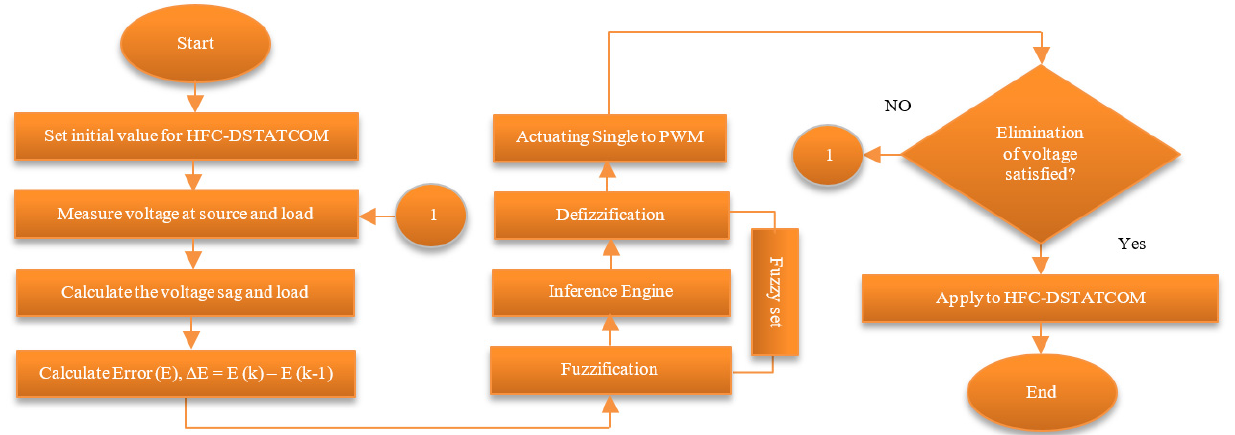
Figure 16. Flowchart of Takagi–Sugeno fuzzy inference system.